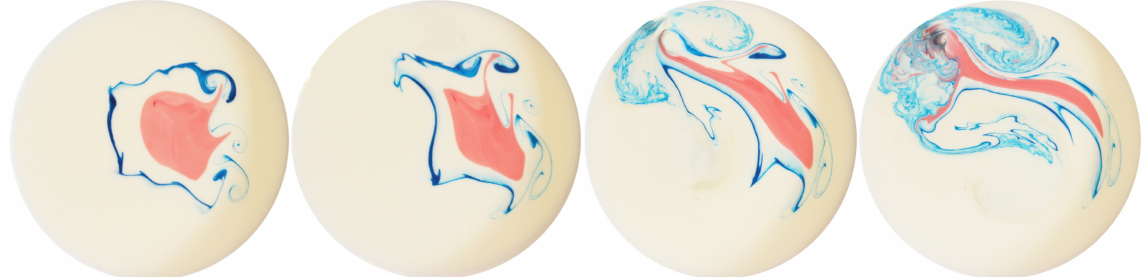
Figure 1. A photograph of the scalar mixing process: three fluids (white, red and blue) arranged on a plate (150 mm diameter) and stirred by a rotating disk (5 mm diameter, 7600 rpm). Pictures taken at about 5 s intervals (courtesy of Zofia Wacławczyk